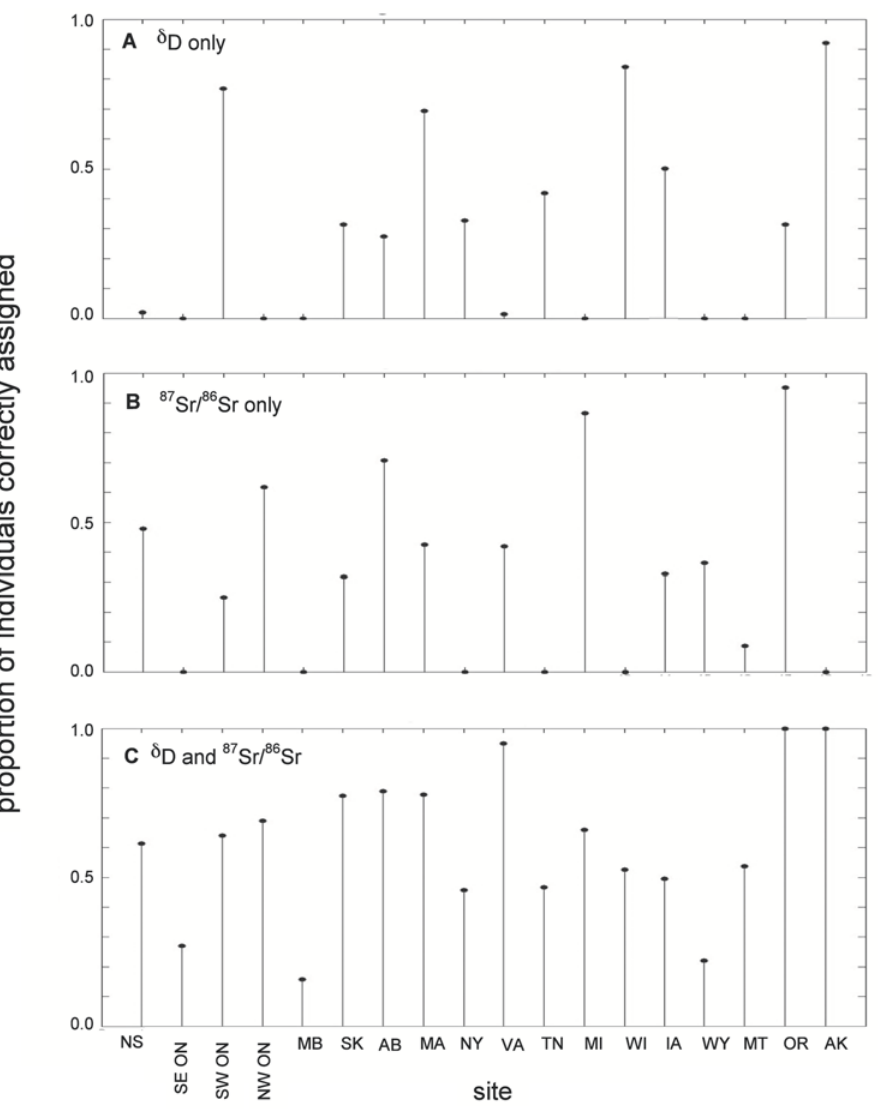
Figure 6. The proportion of Tree swallow correctly assigned to their original site of origin. (a) d D, (b) 87 Sr/ 86 Sr, and (c) d D and 87 Sr/ 86 Sr. Proportion of correct assignments are based on 5000 simulations at each of the 18 breeding sites.